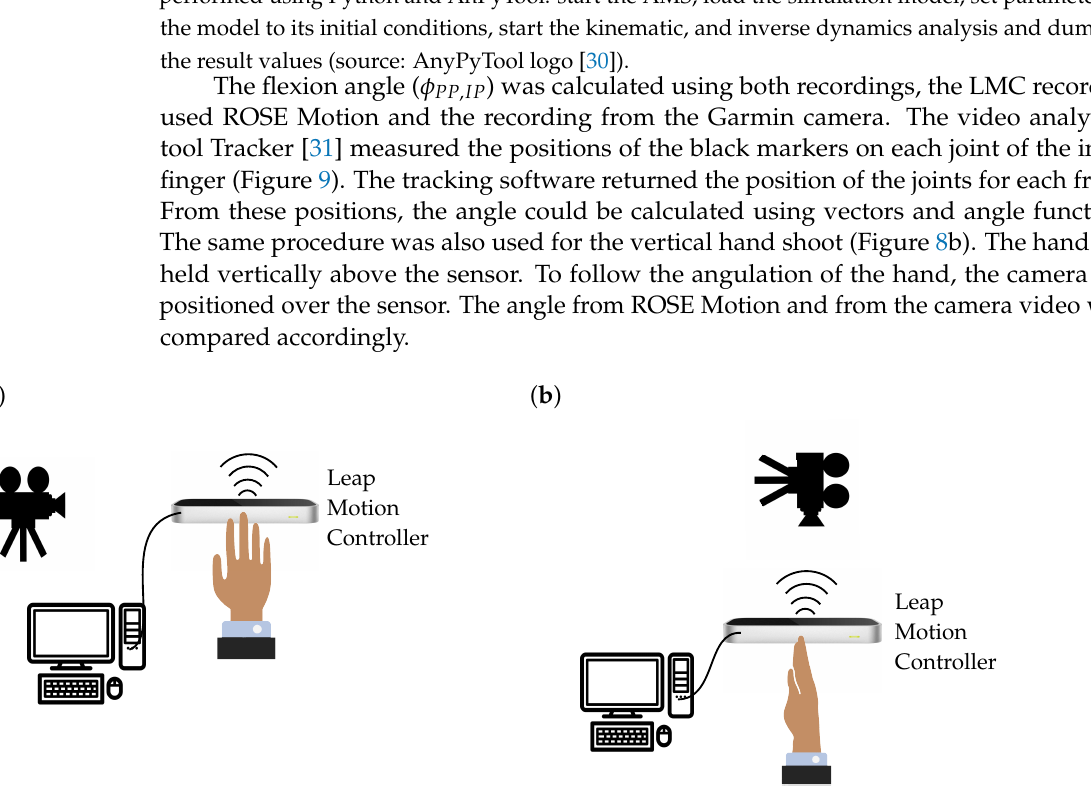
Figure 8. Experimental setup to validate the motion recording of the LMC. ( a ) Experimental setup for a flat hand above the sensor. The position of the camera was on the right to the sensor, to obtain the best view of the index finger making a fist. ( b ) Experimental setup for a vertical hand over the sensor. The position of the camera is above the sensor, to obtain the best view of the index finger making a fist (source: Leap Motion Sensor [28] and icons